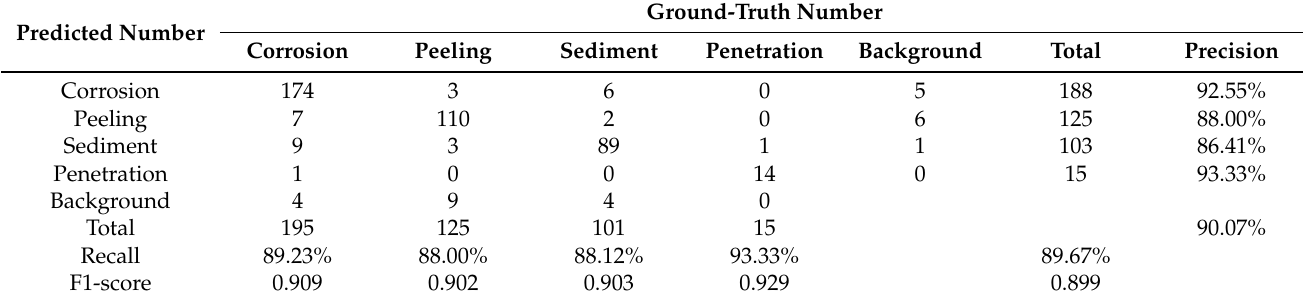
Table 2. Results of the defect detection model on original